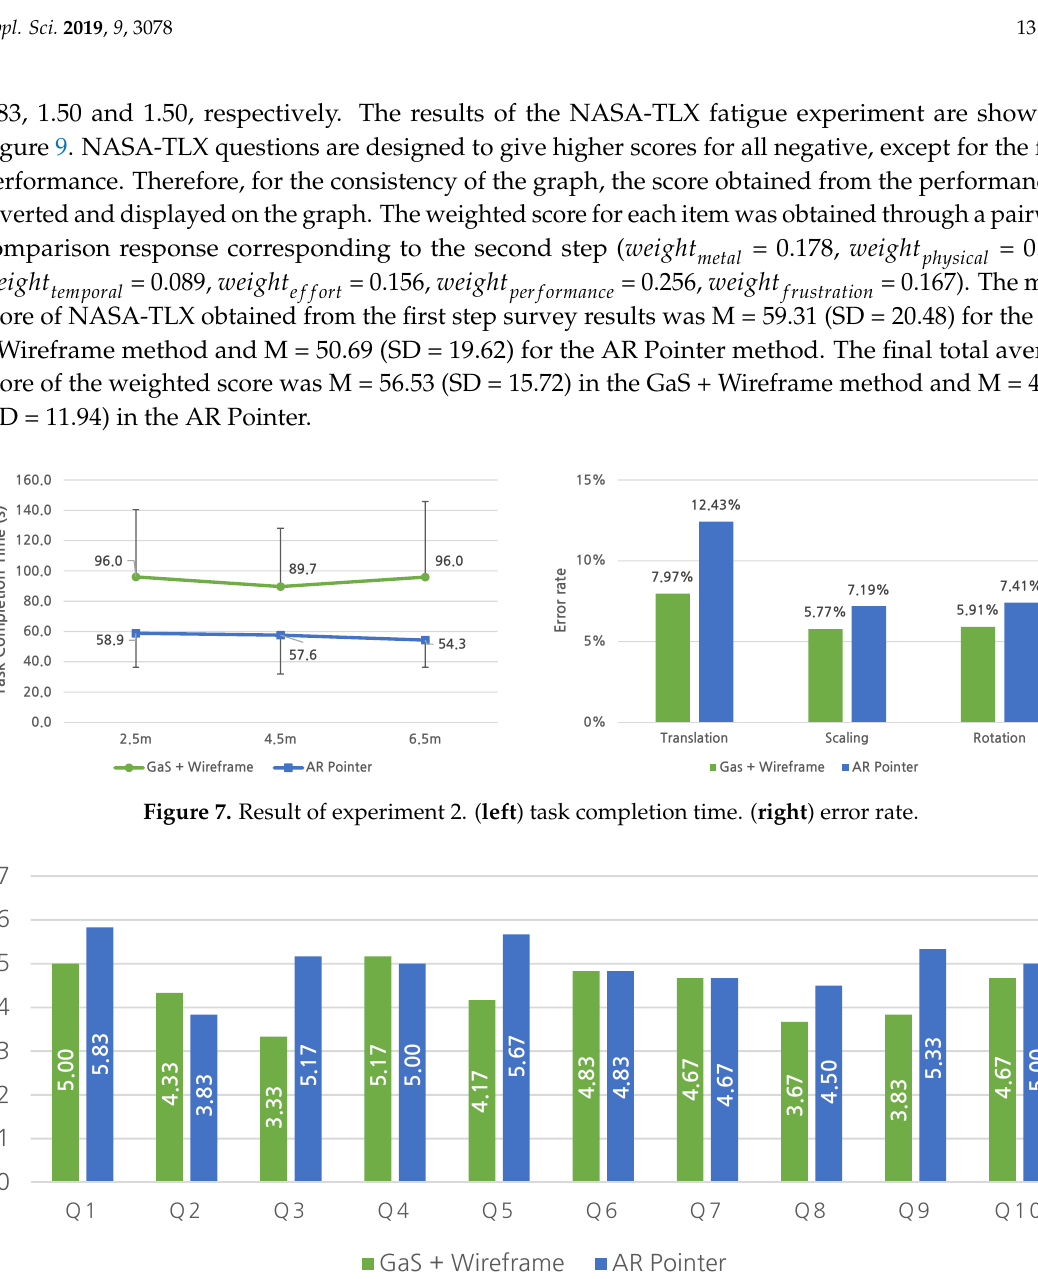
Figure 8. system usability scale (SUS) questionnaire survey result.